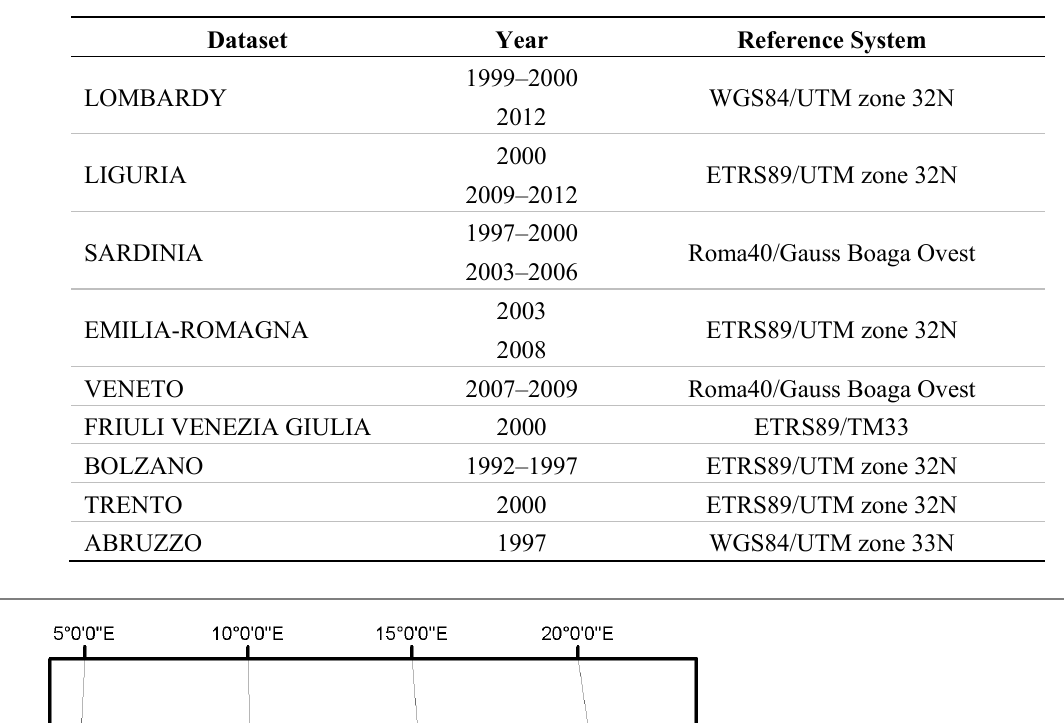
Table 1. Characteristics of the Italian datasets available for the study; it is worth noting that Bolzano and Trento are the two Autonomous Provinces of Trentino-Alto Adige region. (ETRS: European Terrestrial Reference System; TM: Transverse Mercator).